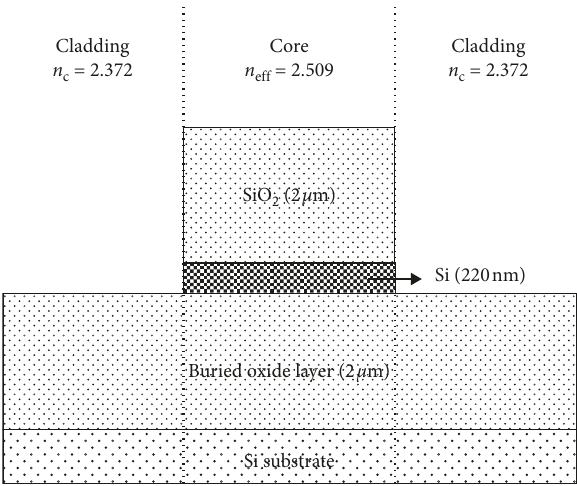
Figure 1: Schematic diagram showing the cross section of a ridge waveguide on an SOI structure.